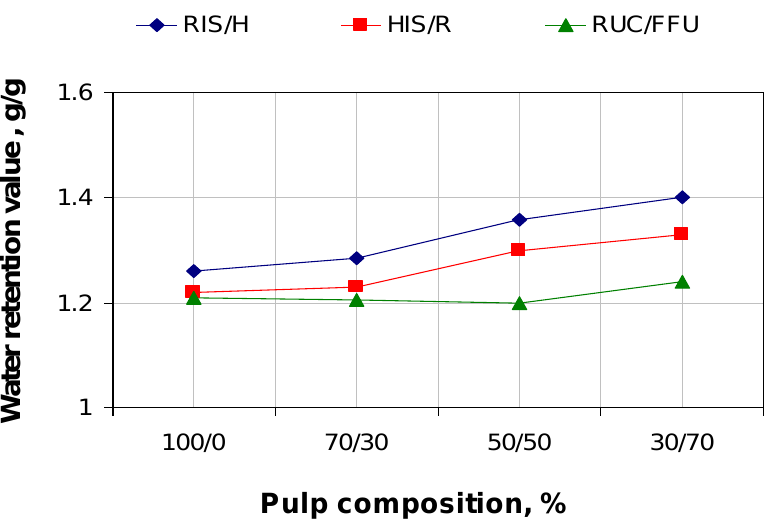
Figure 3. Water retention value (WRV) in relation with pulp composition.